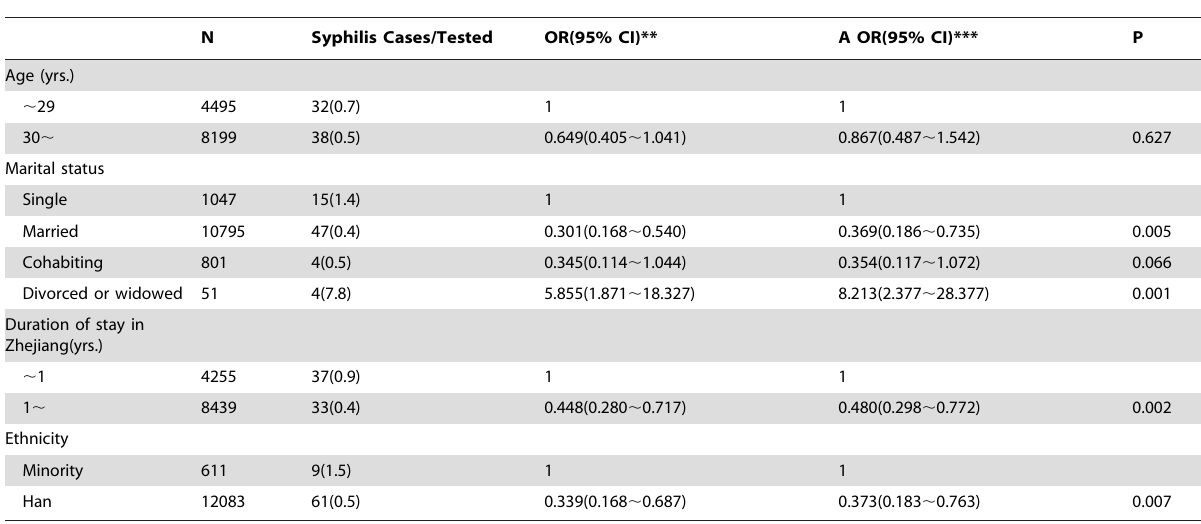
Table 4. Logistic regression analysis of syphilis.